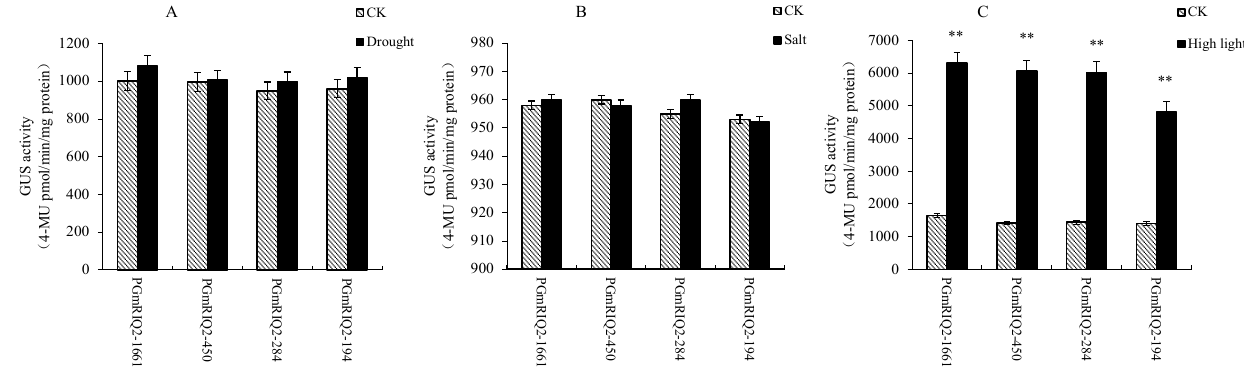
Figure 10. Determination of GUS activity of the transformed GmRIQ2 promoter ( PGmRIQ2 ) in Arabidopsis under abiotic stress. ( A ) Drought: 250 mM mannitol; ( B ) salt: 200 mM NaCl; ( C ) high light: 300 µ mol/m 2 /s. The data are shown as the mean ± SE of three independent replicates. ** indicate significant difference at 0.01 levels.